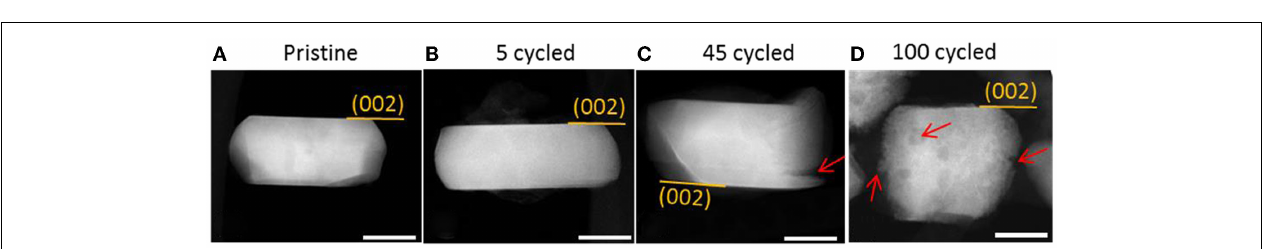
FIGURE 12 | (A–D) Low-magnification STEM-HAADF images to show cycling-induced corrosion. Cracks and pits are highlighted by red arrows. (002) surface planes show strong resistance to corrosion. The scale bars are 30nm (Yan et al., 2015). Reprinted with permission from Yan et al. (2015). Copyright 2015 American Chemical